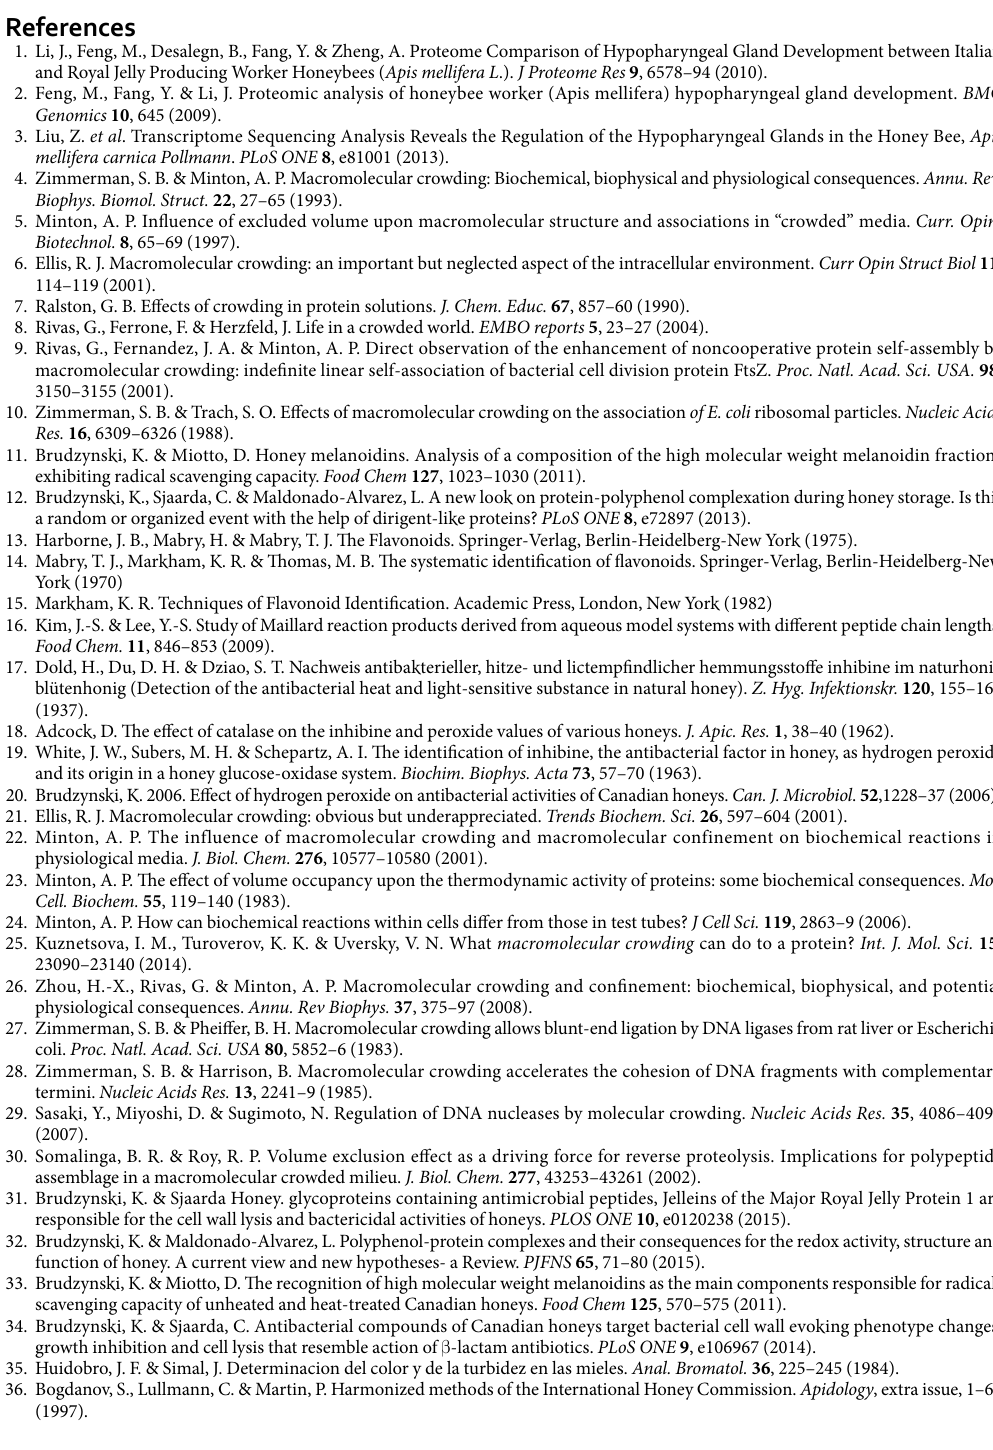
The Synergy HT multidetection microplate reader was used to measure the fluorescence formed during the reaction of honey’s hydrogen peroxide with the AmplexRed reagent (10-acetyl-3,7 dihydroxyphenoxasine). The measurements were conducted at an emission wavelength of 590 nm and an excitation wavelength of 530 nm. The standard curve constructed from the known concentration of H 2 O 2 was used to calculate the hydrogen peroxide concentrations of the honeys. Each of the honeys samples, and the standard curve were tested in triplicate. Statistical